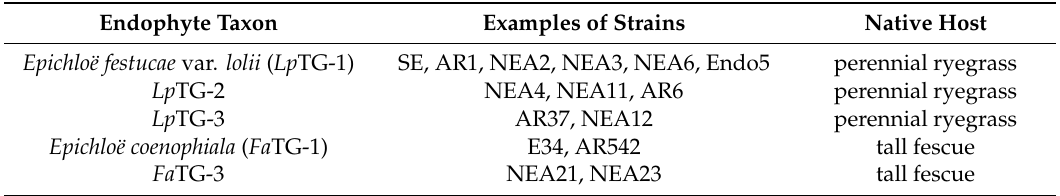
Table 1. Selected Lolium spp. associated Epichloë spp. endophytes.